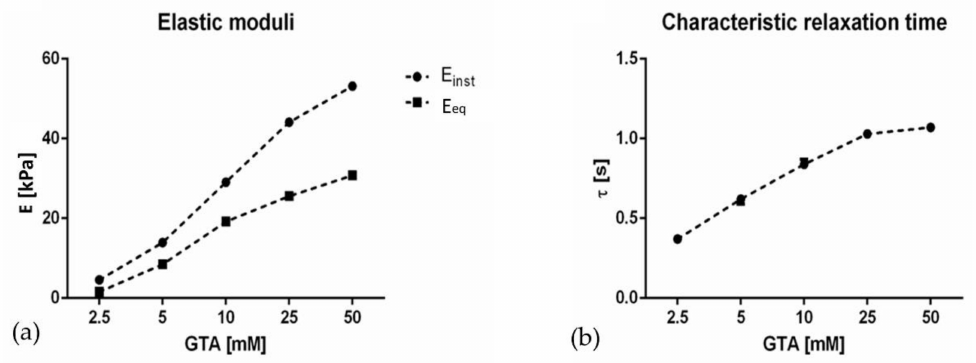
Figure 2. ( a ) Instantaneous E inst ) and equilibrium ( E eq ) elastic moduli and ( b ) characteristic relaxation times of gelatin hydrogels as a function of glutaraldehyde (GTA) concentration. The dashed lines represent linear data interpolation and serve only as a guide to the eye. Error bars are scarcely visible due to their very low values (SEM values are reported in the Supplementary